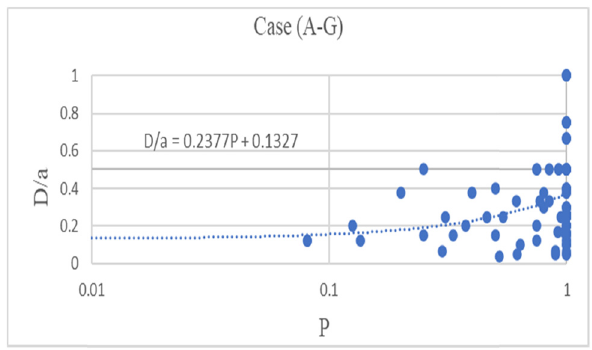
Figure 9: The relation of trunk diameter to sluice gate opening ( D / a ) to a trap index ( p ) for cases ( A – G